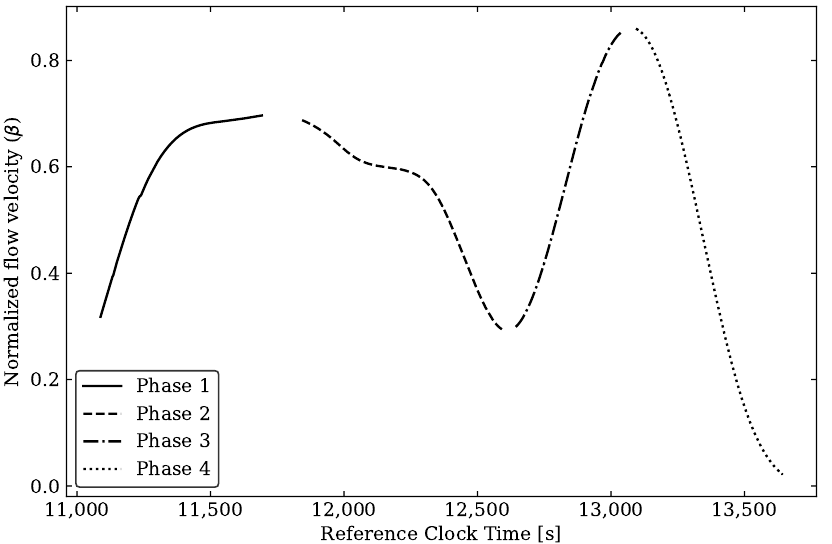
Figure 23. Normalized flow velocity data from discharging mode.